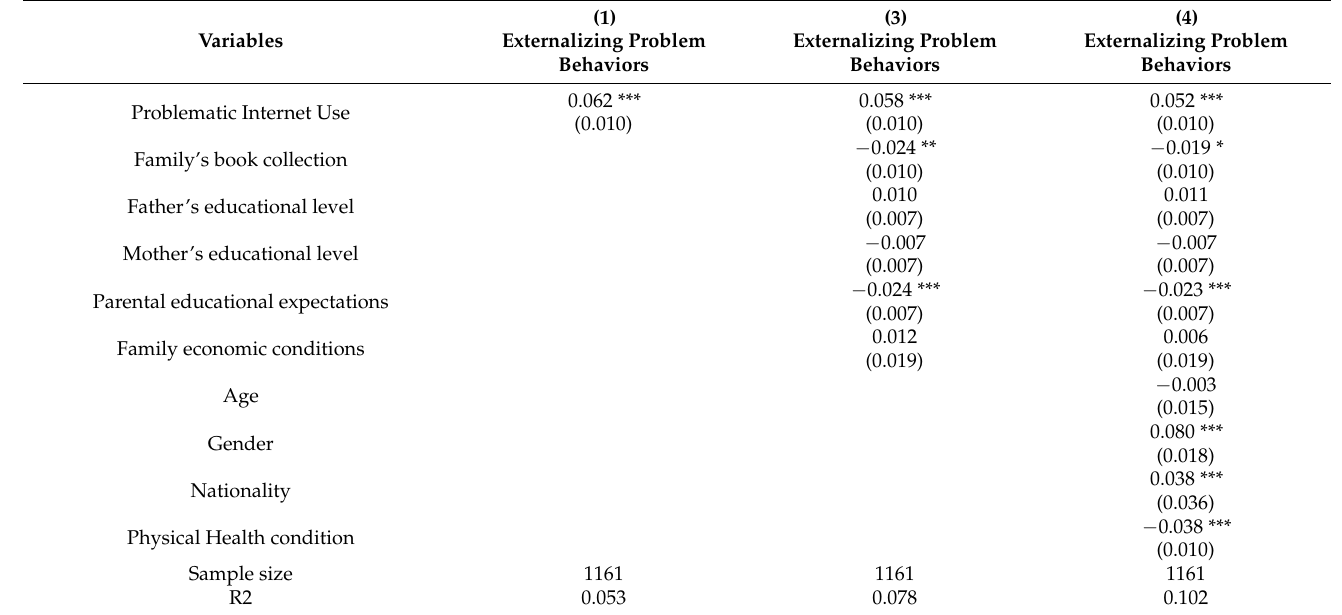
Table 2. OLS regression results for the effect of problematic Internet use on rural adolescent external- izing problem